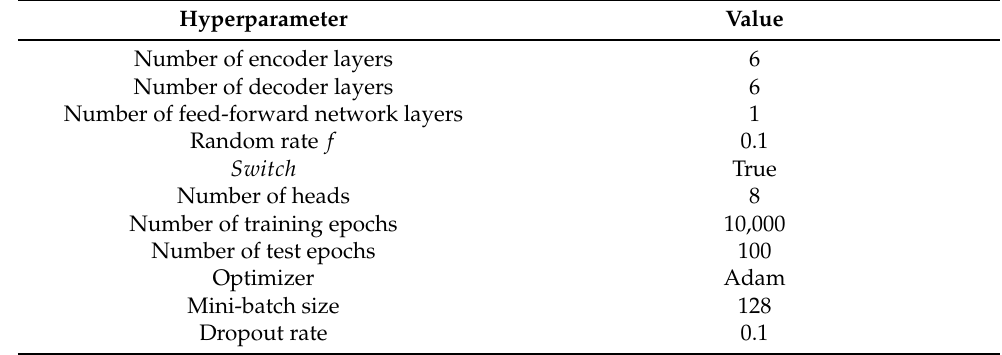
Table 2. List of hyperparameters and their values. Hyperparameter Value Number of encoder layers 6 Number of decoder layers 6 Number of feed-forward network layers 1 Random rate f 0.1 Switch